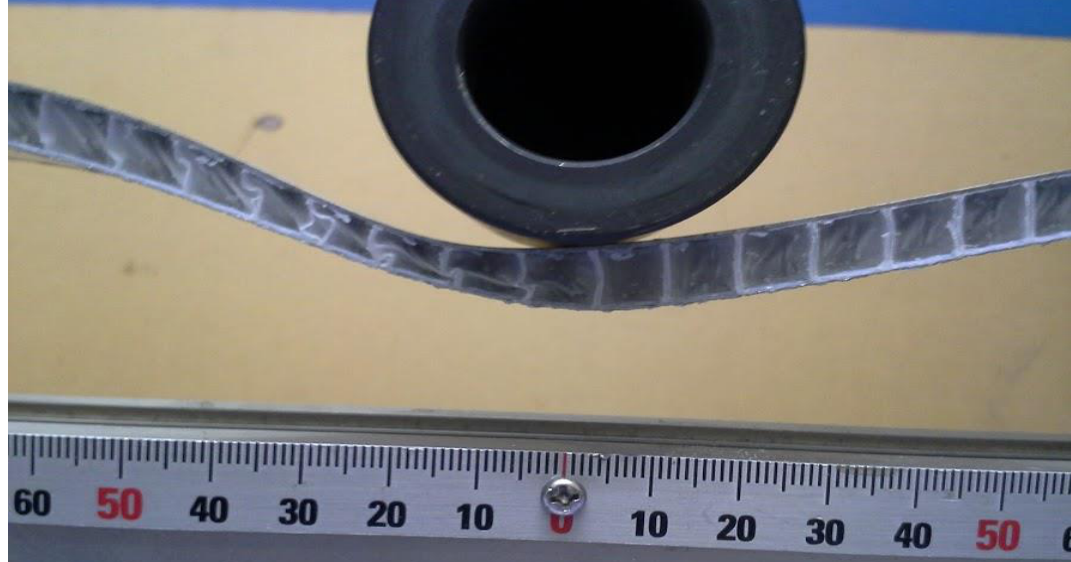
Figure 10. Bending test of sample c3 and failure detail.